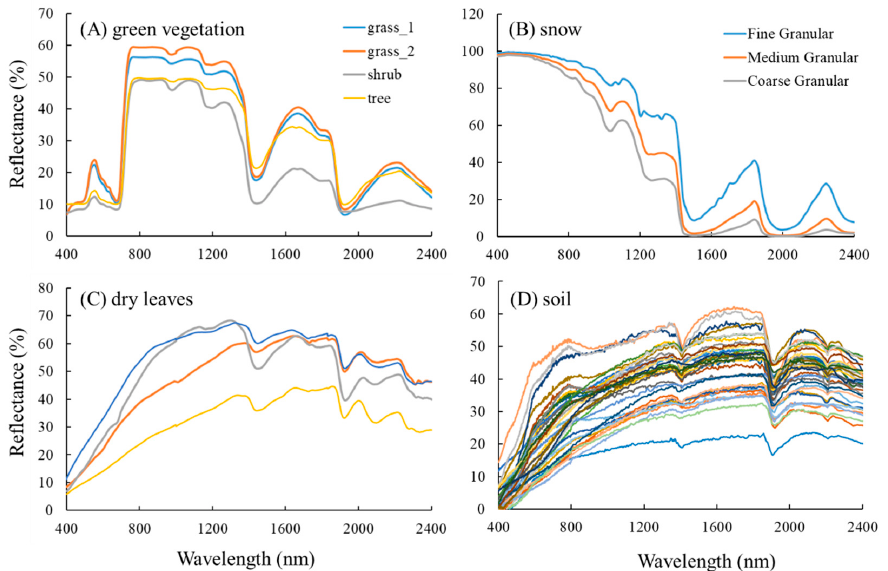
Figure 4. Reflectance spectra from the Aster Spectral Library for ( A ) green vegetation, ( B ) snow, ( C ) dry leaves, and ( D ) soil. There are four types of green vegetation, three types of snow with di ff erent particle sizes, four types of dry leaf, and 25 types of soil.